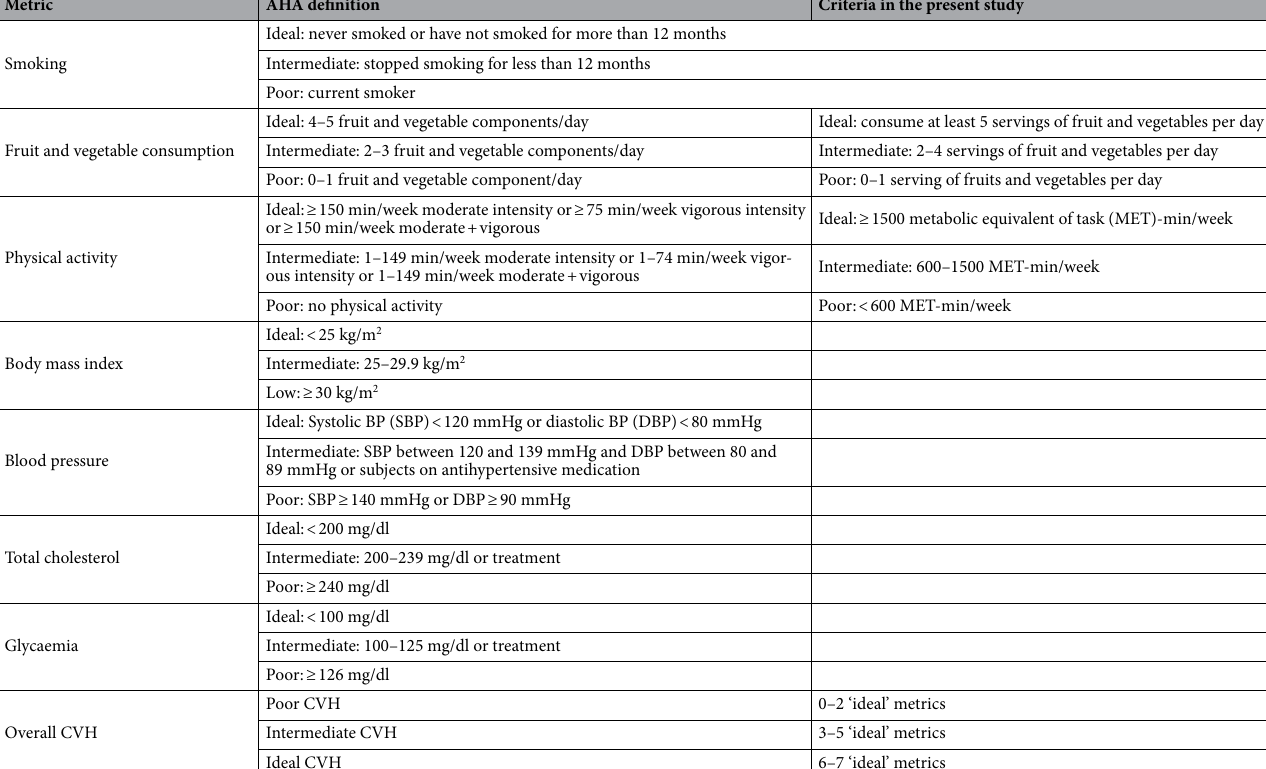
Table 1. Definitions of ideal, intermediate, and poor cardiovascular health for each